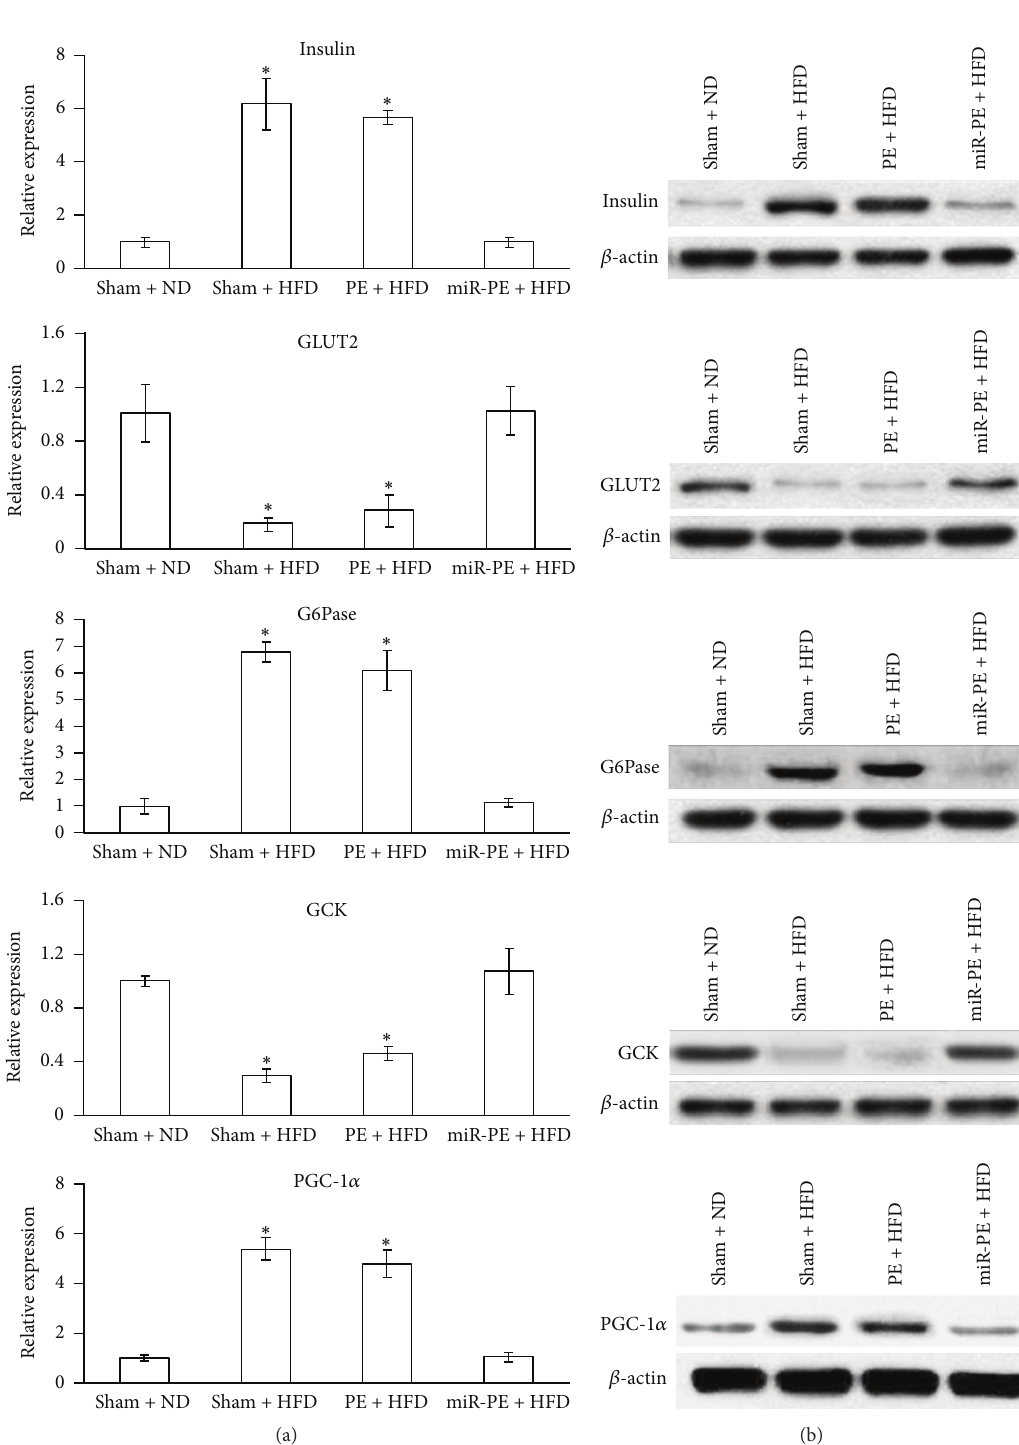
Figure 6: Assessment of hormones and enzymes involved in gluconeogenesis and glycogenolysis in pancreas. (a) mRNA levels of insulin , GLUT2 , G6Pase , GCK , and PGC-1 𝛼 . All values are given as mean; error bar represents standard error. ∗ 𝑝 < 0.05 , compared with Sham + ND group. (b) Western blot results of protein level of the same